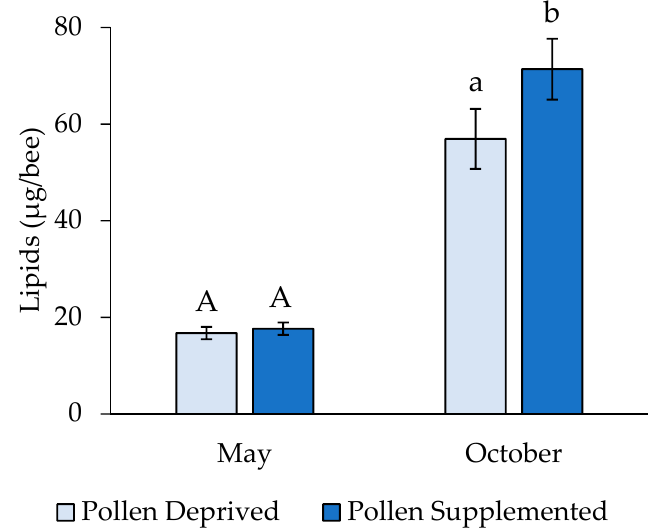
Figure 4. Lipid concentrations from 4th/5th instar honey bee larvae (mean ± SE). Letters indicate significant differences between feeding treatments within a replicate.